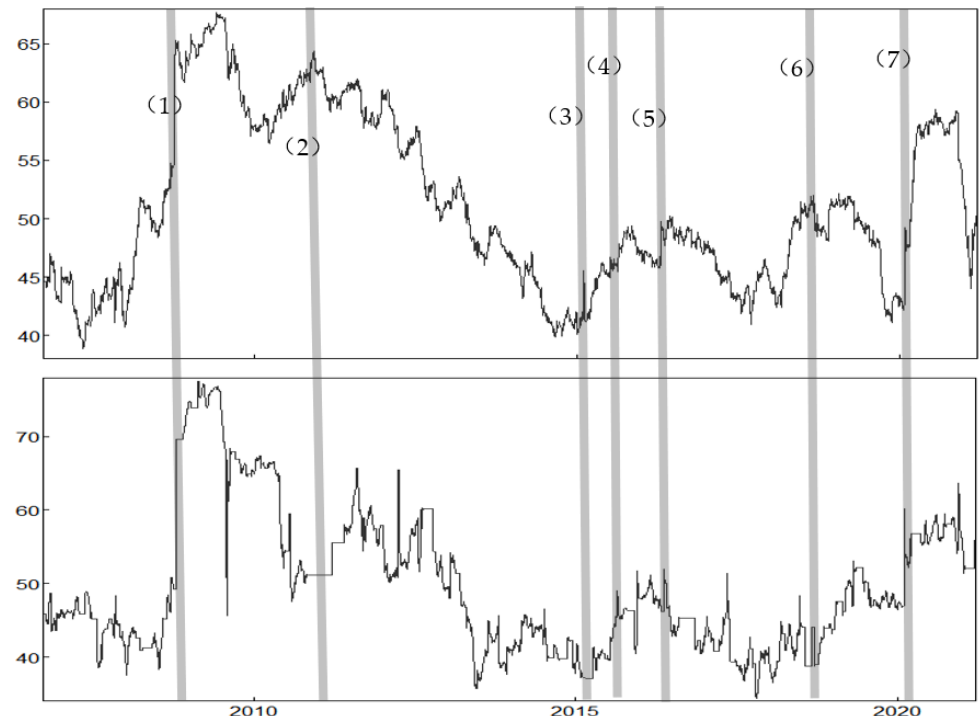
Figure 1. The total volatility spillover of the rolling sample. Notes: (1) The top figure is based on the logarithmic yield and the bottom figure is based on VaR; the length of the forecast is 10 days and the rolling window is 200 days. (2) Event ( 1 ): In August 2008, the international financial crisis began to lose control, and many large financial institutions closed or were supervised by the government; Event ( 2 ): On 11 March 2011, a magnitude 9.0 earthquake and tsunami occurred in Japan; Event ( 3 ): On 10 February 2015, international metals prices plunged 7.2% during the flash crash of the stock markets; Event ( 4 ): In August 2015, a major stock market crash in China occurred; Event ( 5 ): In June 2016, UK Brexit referendum was approved; Event ( 6 ): On 31 August 2018, China’s domestic food prices increased by 25.2% daily; Event ( 7 ): In March 2020, the World Health Organization declared COVID-19 outbreak a pandemic.